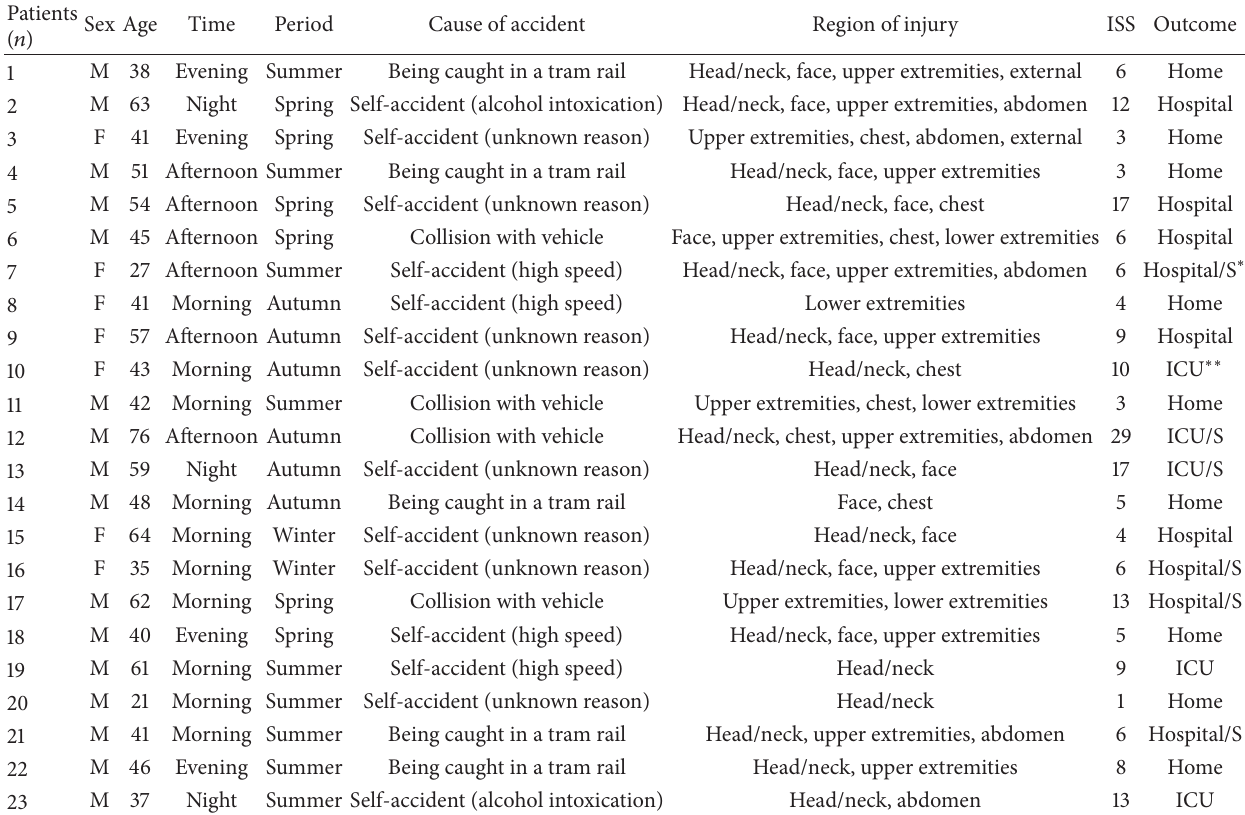
Table 2: E-cyclists’ characteristics.